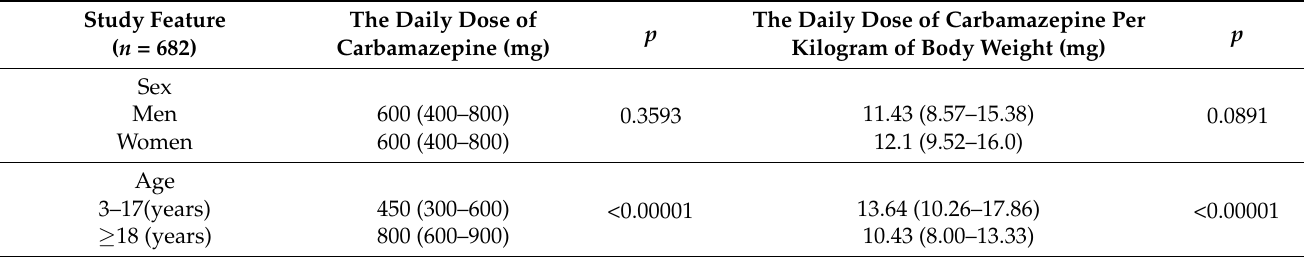
Figure 1. The carbamazepine concentration (µg/mL) depending on the main reason for hospitalization (marker—median; edges of the box—upper and lower quartile; whiskers—range of non-outlier values). Table 3. Pharmacotherapy with carbamazepine in the study population depending on selected clinical parameters (median (lower quartile–upper quartile) or number